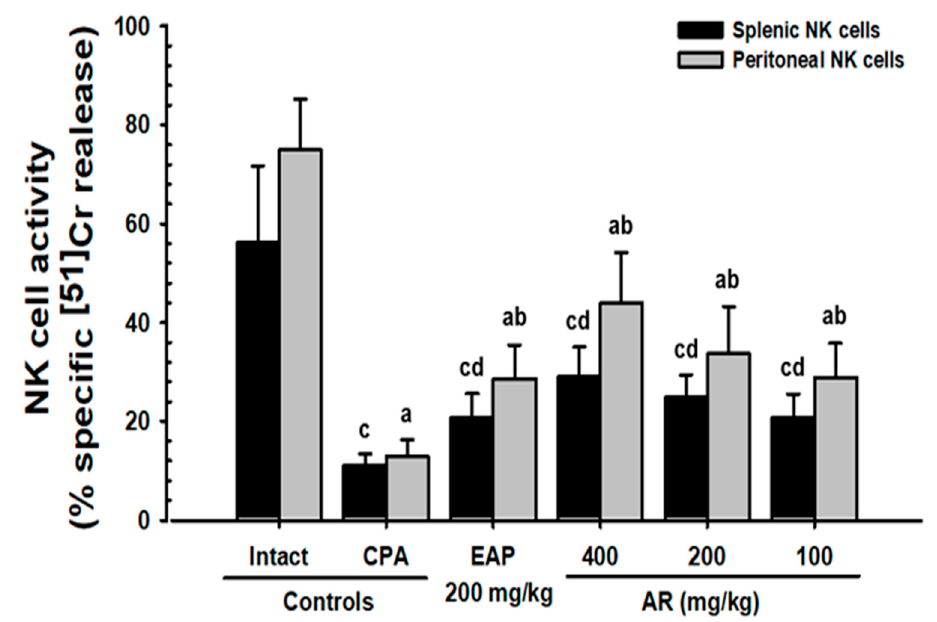
Figure 6. Effects on NK cell activity. CPA = cyclophosphamide; EAP = exopolymers purified from A. pullulans ; AR = Astragali Radix (Roots of A. membranaceus Bunge) extracts; NK = Natural killer; THSD = Tukey’s honest significant difference; DT3 = Dunnett’s T3; a p < 0.01 as compared with intact control by THSD test; b p < 0.01 as compared with CPA control by THSD test; c p < 0.01 as compared with intact control by the DT3 test; d p < 0.01 as compared with CPA control by the DT3